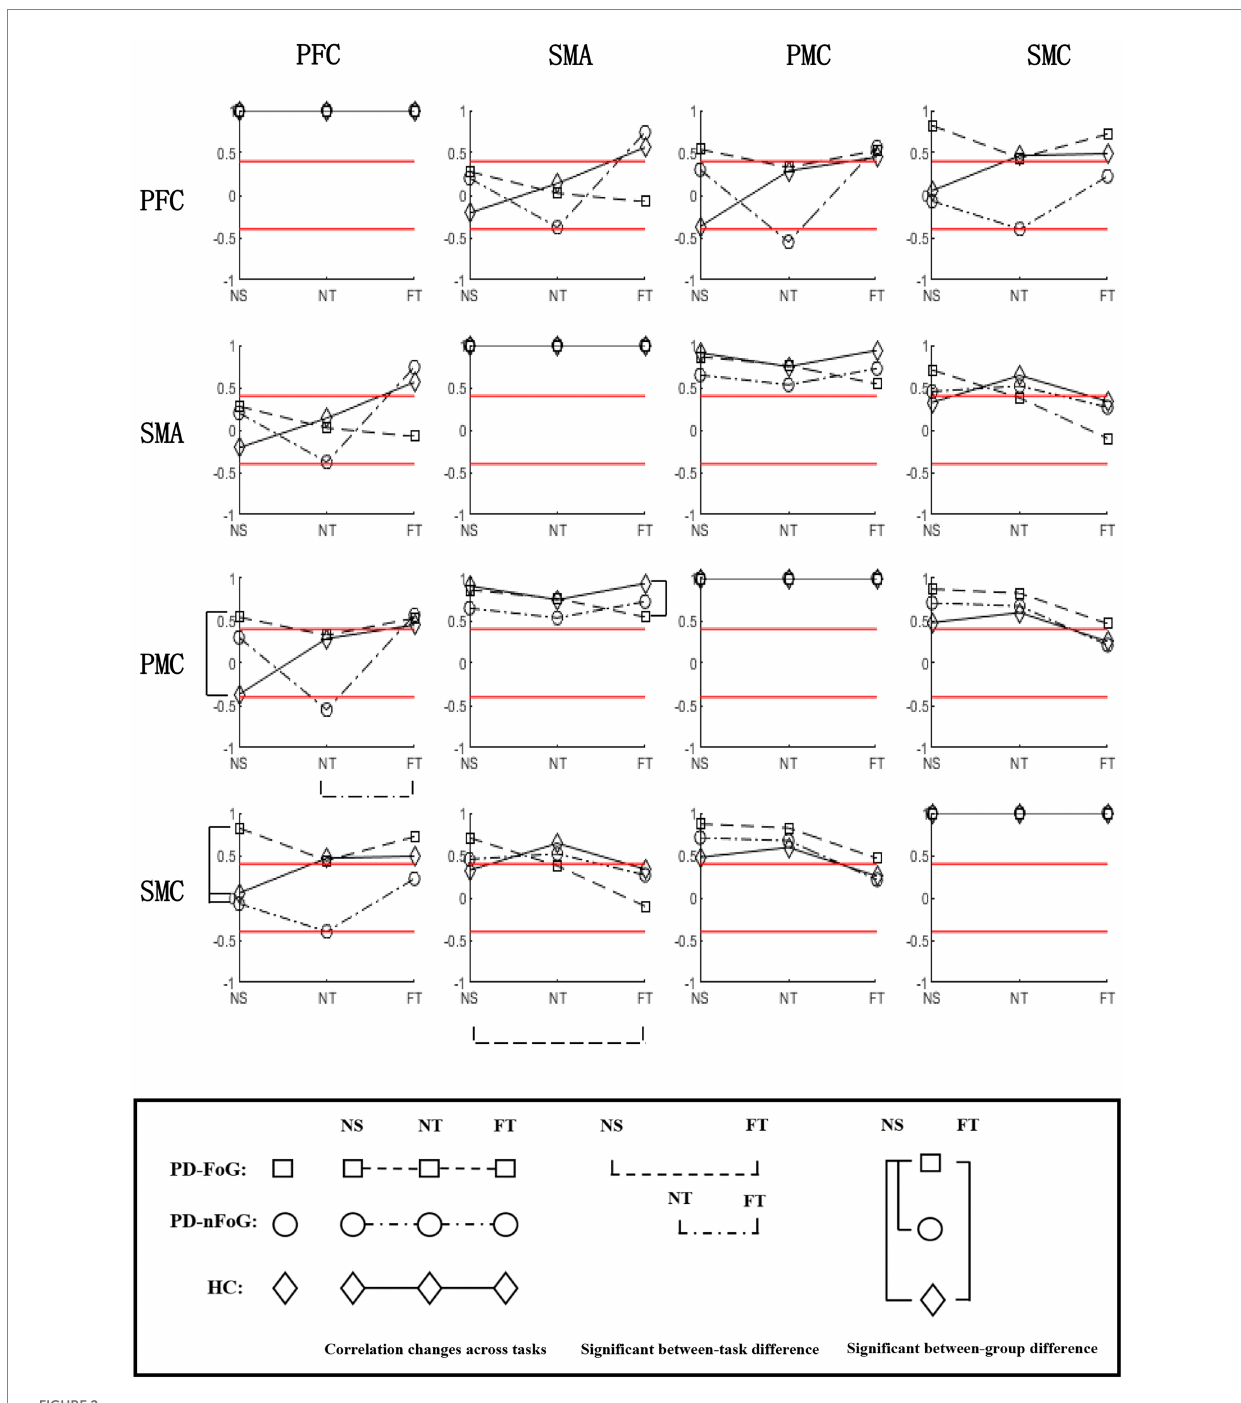
FIGURE 2 Correlation matrix of ∆ HBO 2 between ROIs during different tasks in each participant group. For each subplot, the values of the y-axis are the correlation coefficients of Δ HBO 2 between ROIs during each task in each participant group. On the x-axis, NS, NT, and FT represent the three locomotion tasks, namely normal stepping, normal turning, and fast turning, respectively. The icons □ , ○ , and ◇ in each subplot denote the correlation coefficients of Δ HBO 2 between ROIs in PD-FoG patients, PD-nFoG patients, and HCs, respectively. The dashed, dash-dotted, and solid lines in each subplot denote the change of correlation coefficients of Δ HBO 2 between ROIs from NS to NT to FT in PD-FoG patients, PD-nFoG patients, and HCs, respectively. Red lines signify a correlation coefficient value at 0.4 or-0.4, which is the threshold for moderate correlation (Evans, 1996). Vertical square brackets indicate significant between-group difference in z-scores of correlations coefficients during a task ( p < 0.05). The type and the x-axis position of the icons marked by brackets indicate the corresponding groups and tasks explained above. Horizontal square brackets indicate significant between-task difference in the z-scores of the correlation coefficients within a participant group. The dashed, dash-dotted lines of the horizontal square brackets indicate PD-FoG patients and PD-nFoG patients, respectively. PFC, prefrontal cortex; PMC, premotor-motor cortex; SMA, supplementary motor area; SMC, sensorimotor cortex; ROI, region of